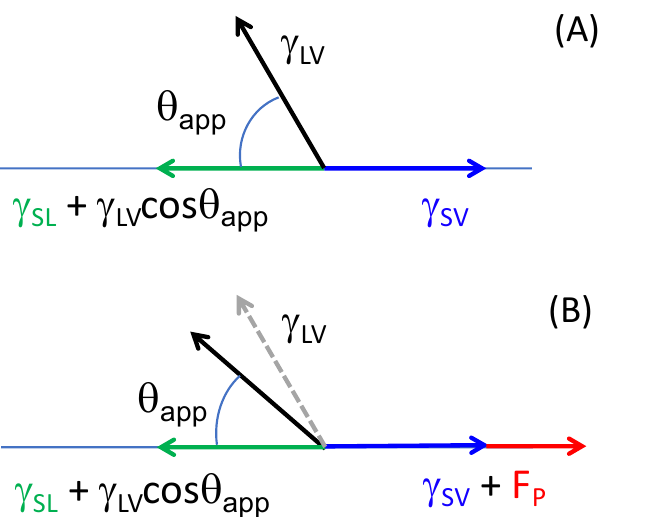
Figure 5. Forces acting on the receding contact line for a drop of a pure fluid ( A ) and for a drop of a dilute polymer solution ( B